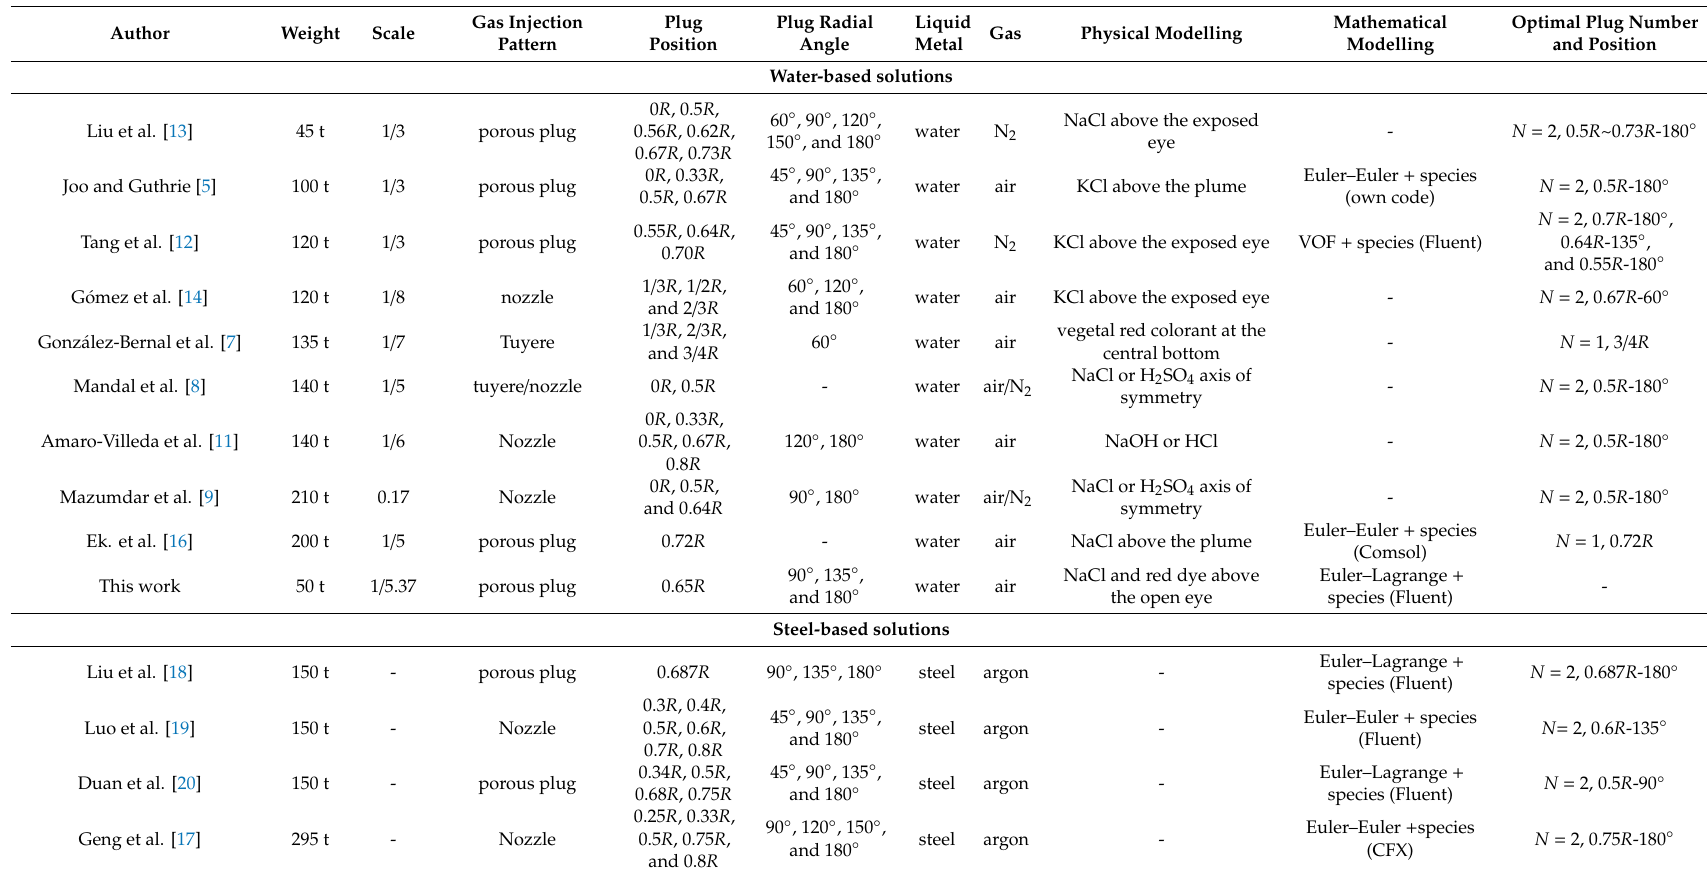
Table 1. Physical and mathematical modelling of gas-stirred ladles of di ff erent